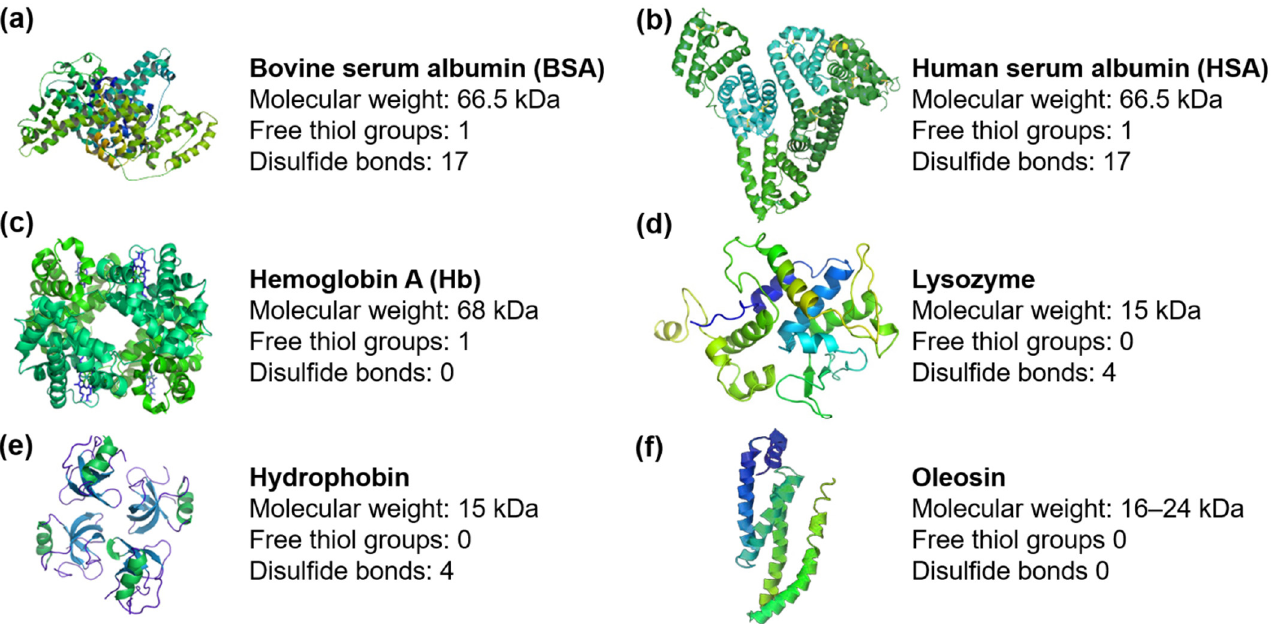
Figure 2. Proteins involved in MB shell stabilization: ( a ) bovine serum albumin (BSA), ( b ) human serum albumin (HSA), ( c ) hemoglobin, ( d ) lysozyme, ( e ) hydrophobin, ( f ) oleosin. For all proteins, characteristics such as molecular weight, numbers of free thiol groups, and disulfide bonds involved in MB formation and further functionalization, are provided.